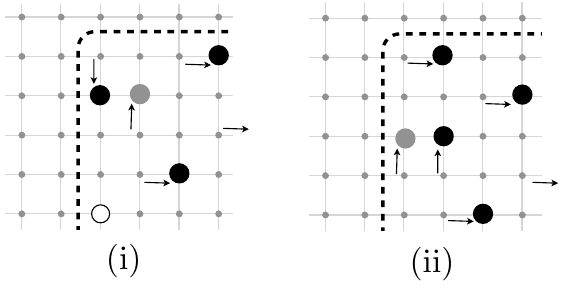
Figure 14: The movement of guards in response to an